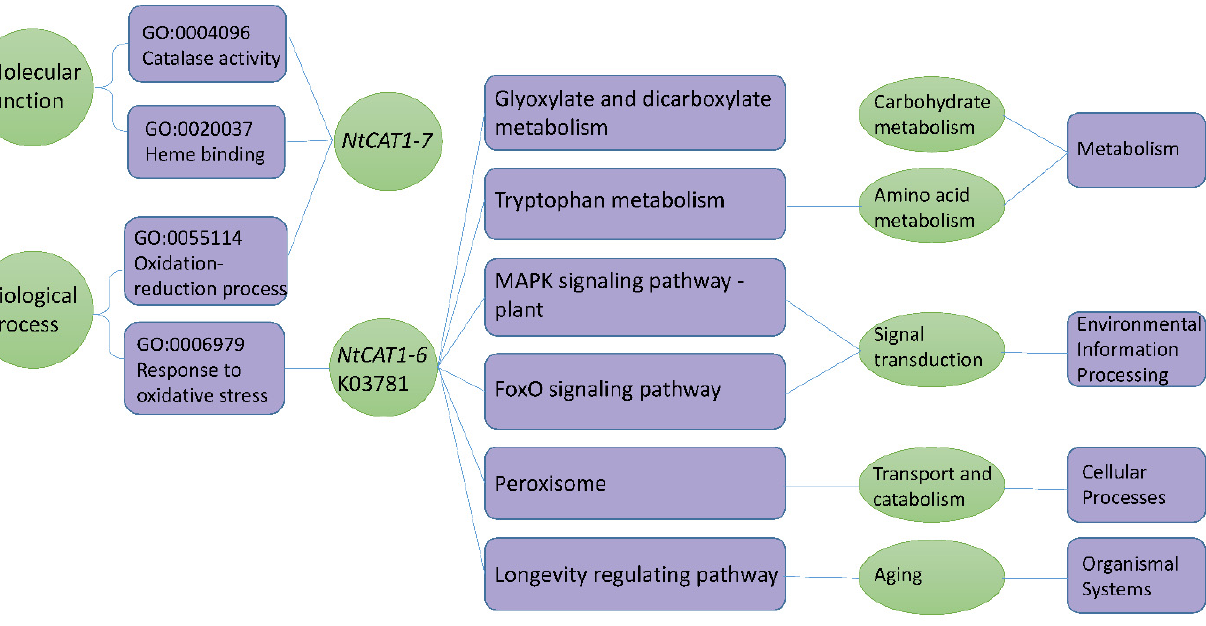
Figure 5. Function annotation of NtCATs based on Gene Ontology (GO) and KEGG pathways.